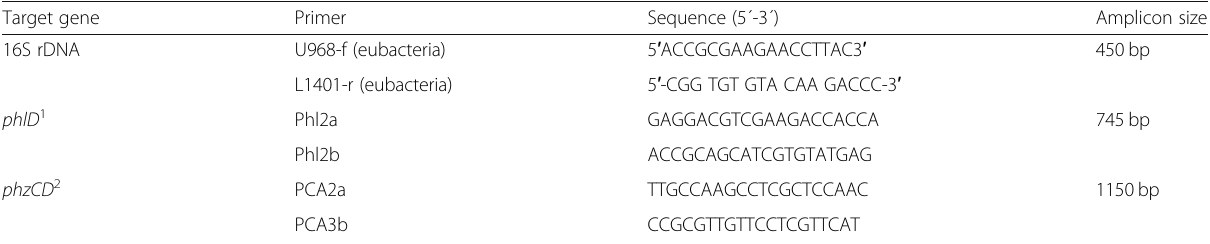
Table 1 Primers employed for identification of Eubacterial antagonistic strains and screening for the antibiotic producing ability of fluorescent pseudomonades (Raaijmakers et al.